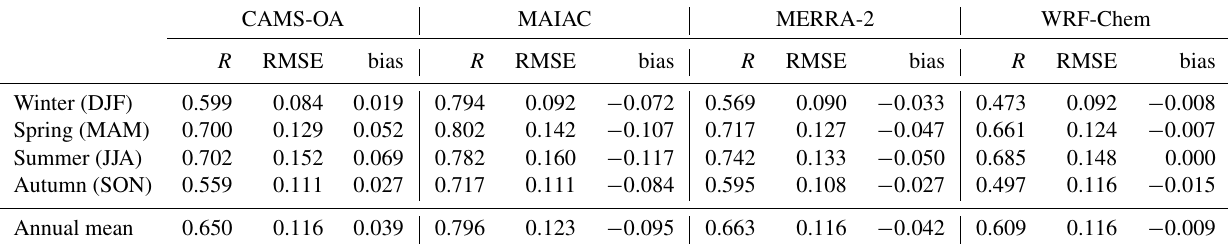
Table 5. Pearson correlation coefficient ( R ), root mean square error (RMSE), and mean bias calculated for seasonally and annually averaged 2015–2016 AOD geographic distributions from CAMS-OA, MAIAC, MERRA-2, and WRF-Chem with respect to MODIS-DB&DT AOD. CAMS-OA MAIAC MERRA-2 R RMSE bias R RMSE bias R RMSE bias R RMSE bias Winter (DJF) Spring